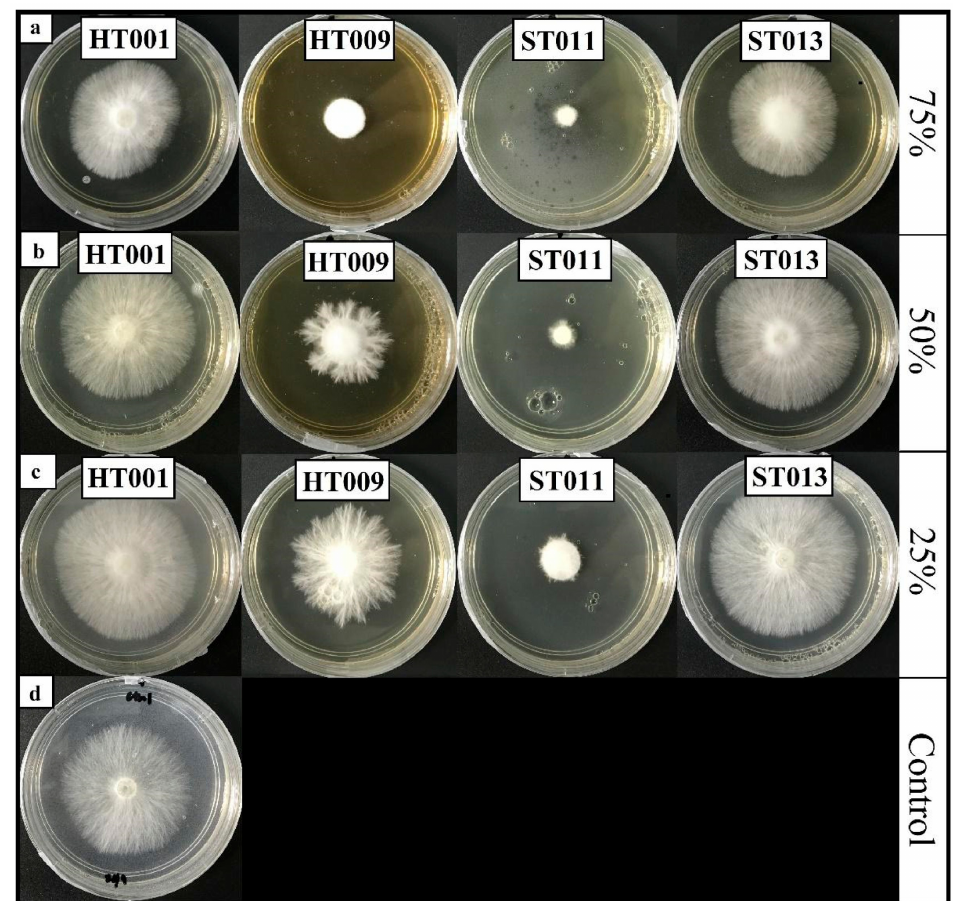
Figure 2. Effects of culture filtrate of Trichoderma koningiopsis (HT001), Trichoderma spirale (HT009), Trichoderma asperellum (ST011), and Trichoderma reesei (ST013) assayed at concentrations of ( a ) 75, ( b ) 50, and ( c ) 25% in the potato dextrose agar against Rigidoporus microporus . Pictures referred to 5 days after inoculation. ( d ) Control